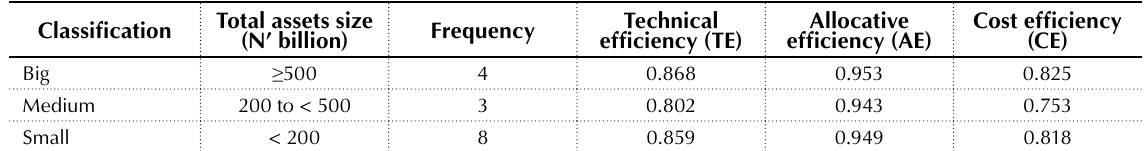
Table 9. Measured mean efficiency of the deposit money banks in 2007